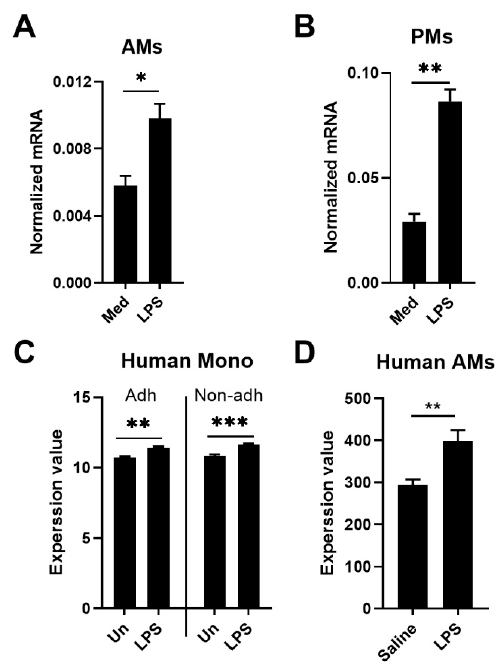
Figure 1. LPS induces expression of Tet2/TET2 in mouse and human macrophages. ( A ) Tet2 expression in murine alveolar macrophages (AMs) after stimulation with 100 ng/mL LPS for 12 h; ( B ) Tet2 expression in murine peritoneal macrophages (PMs) after stimulation with 100 ng/mL LPS for 12 h; ( C ) TET2 expression in adherent (Adh) and non-adherent (Non-adh) human monocytes (Human mono) before (Un) and 24 h after stimulation with 10 ng/mL LPS; ( D ) TET2 expression in human AMs collected 6 h after bronchial instillation of LPS (4 ng/kg body weight) or (in the contralateral lung) saline. mRNA expression was normalized to HPRT mRNA ( A , B ). n = 6. Data is shown as bar graphs with mean ± SEM. The p values were calculated using Mann–Whitney test ( A , B and D ) or paired t -test (C). * p < 0.05, ** p < 0.01, *** p < 0.001.